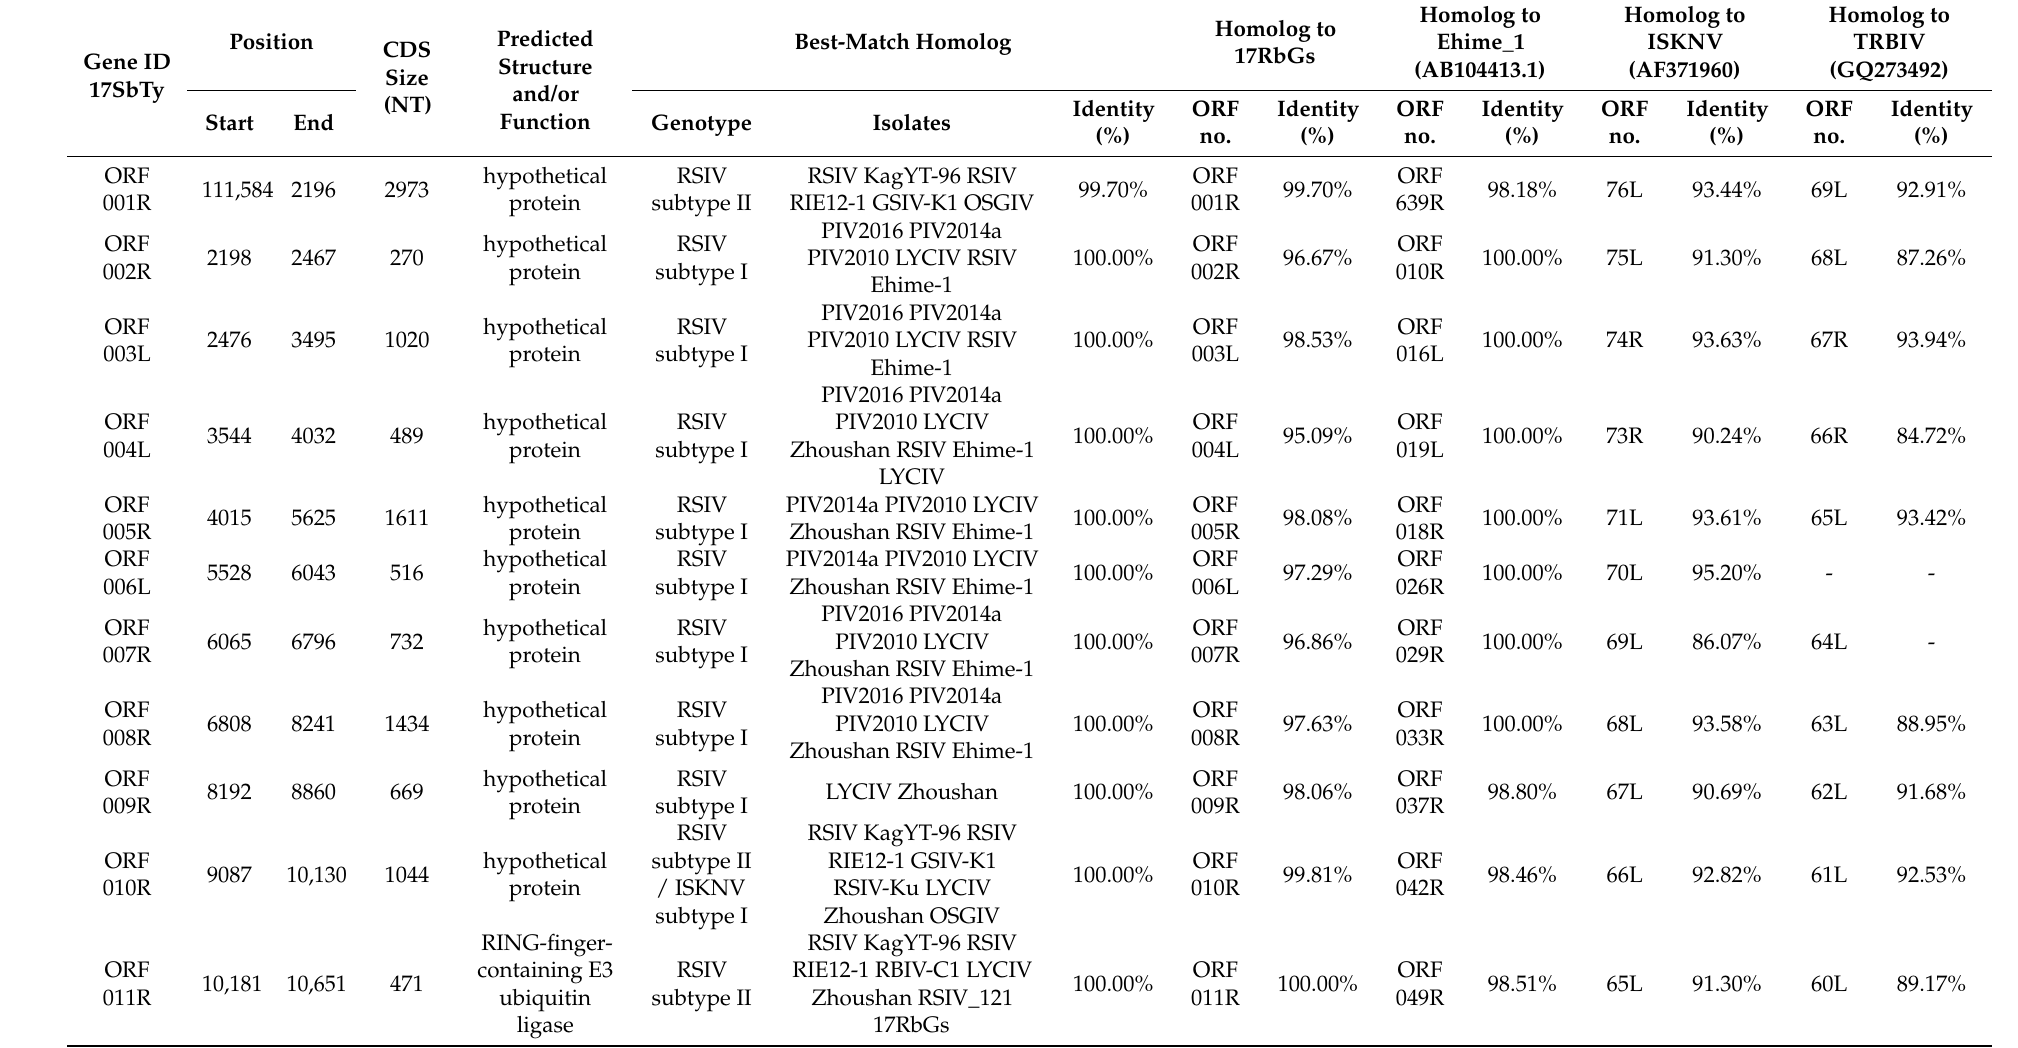
Table A2. Predicted ORFs based on a comparison of isolates 17SbTy to 17RbGs and representative